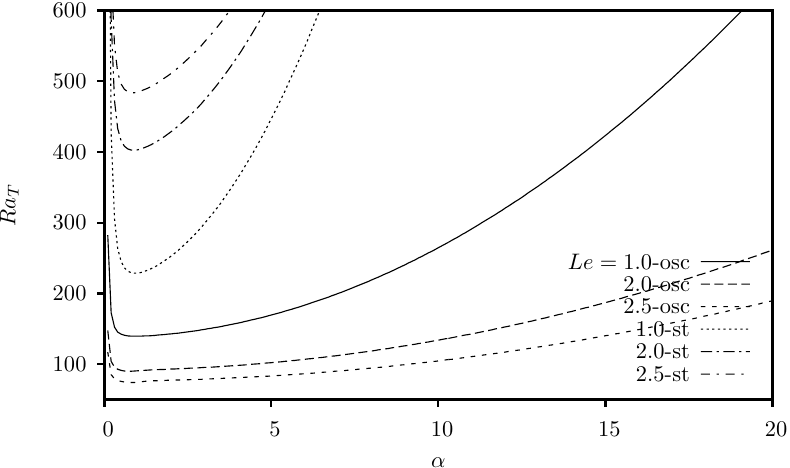
Figure 7. Effect of Le on the marginal stability curves for stationary and oscillatory convection with respect to the wave number α